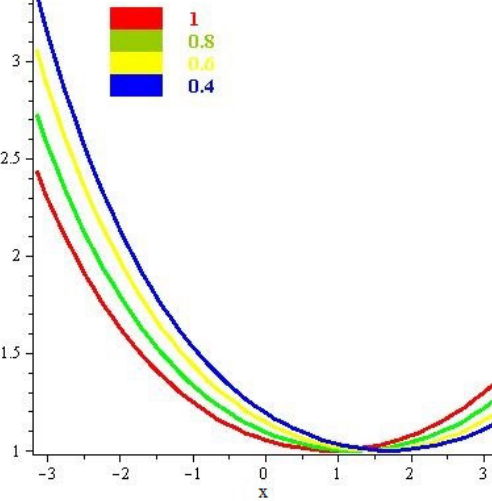
Figure 8. The graph of Example 2, for different value of γ